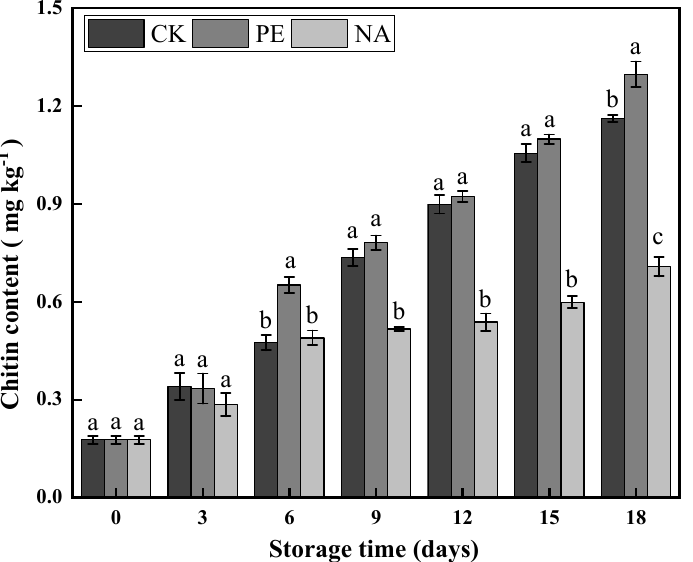
Figure 5. Effects of different types of packaging on chitin content in stipe elongation area of F. velutipes .